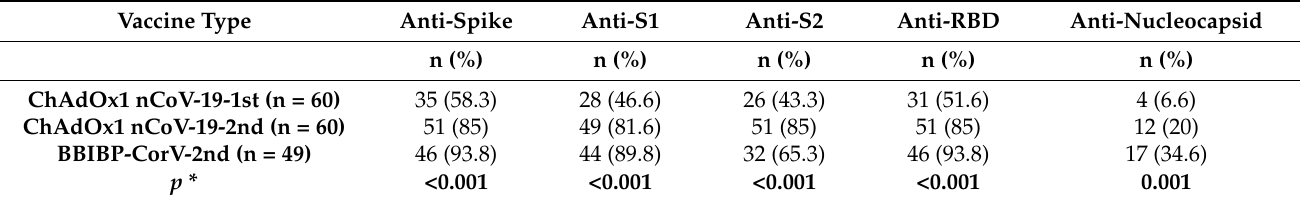
Table 2. Humoral immune response after the first dose of the ChAdOx1 nCoV-1 vaccine and the second dose of both vaccines (n = 109).